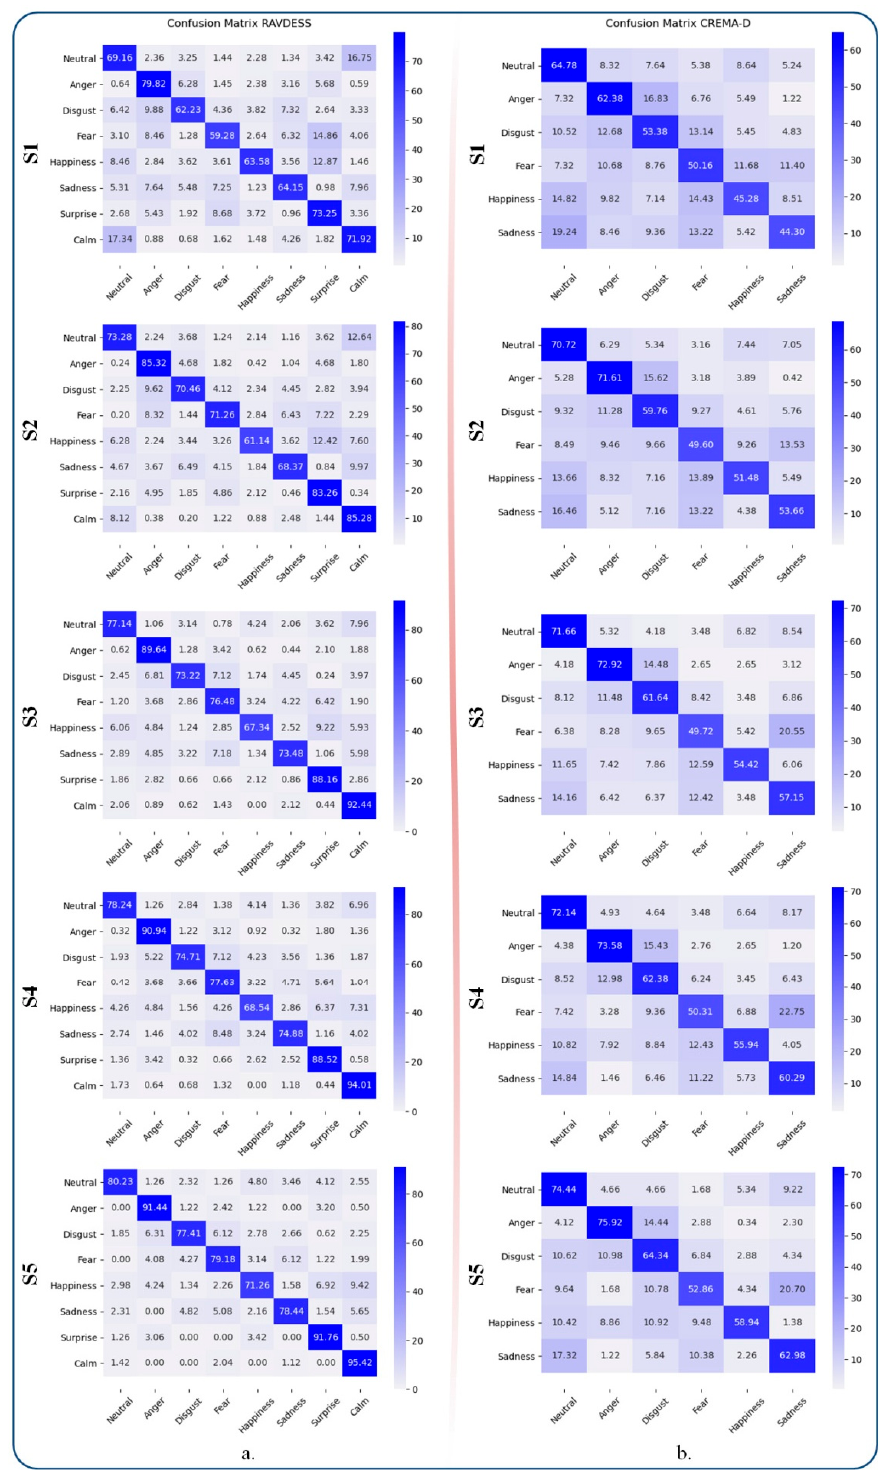
Figure 9. The confusion matrixes on the evaluation dataset ( a ) RAVDESS and ( b ) CREMA ‐ D. (S1). The baseline method; (S2). SE ‐ ResNet with multi ‐ stage training; (S3). SE ‐ ResNet with GhostVLAD layer; (S4). The SE ‐ ResNet with the GhostVLAD layer and the classical triplet loss function; (S5). The proposed framework, which involves SE ‐ ResNet with the GhostVLAD aggregation layer and emotion constraint loss.